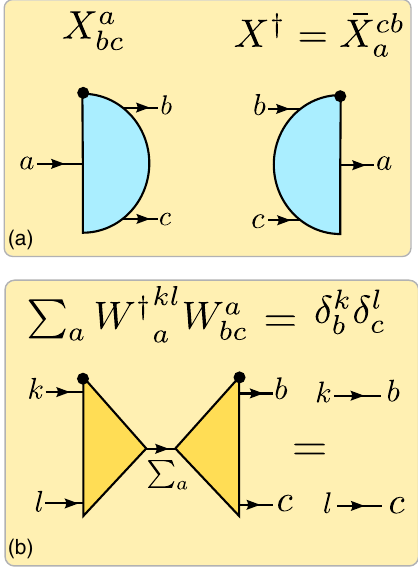
FIG. 2. Graphic representation of tensors and their contractions. Tensors are generalized vertexes (geometric shapes) whose legs are represented by dangling arrows. (a) A tensor with three legs X a . The upper indexes are incoming legs while lower indexes are bc outgoing legs. Complex conjugation is denoted by mirror reflection of the vertex. Different colors denote different tensors. Indexes are ordered clockwise, starting from the solid dot on the vertex. The contraction of two tensors is denoted by an arrow joining them. The dagger operation X † involves both the complex conjugation of the elements of the tensor and the inversion of the arrows attached to its legs. As a consequence, the order of the legs ¯ X cb also changes X † ¼ [67]. (b) An isometric tensor (or simply a isometry) is always represented by a triangular vertex. A tensor W is isometric if there is a specific choice of legs, which identifies two vector spaces U and V , such that when W is contracted with W † through the legs in U , the result is the identity tensor in V . In the figure, U is spanned by the leg a while V is spanned by the two legs b and c